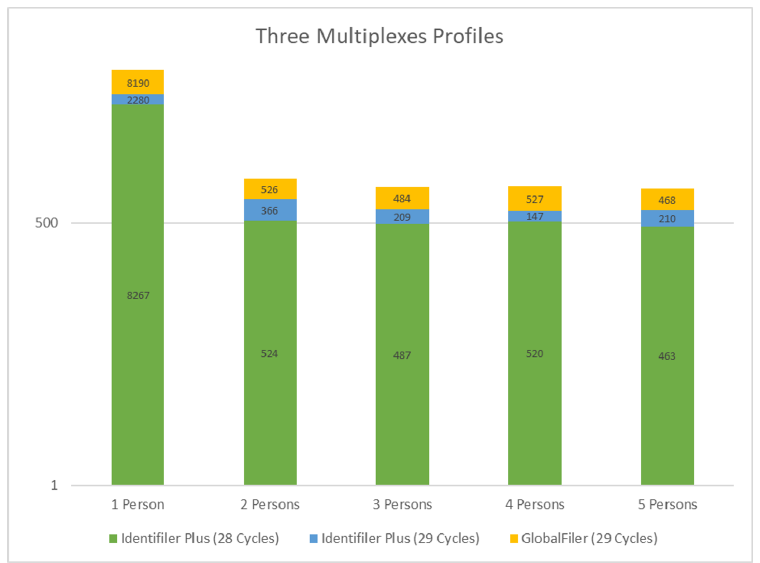
Figure 16. The three multiplexes profiles (16 loci).